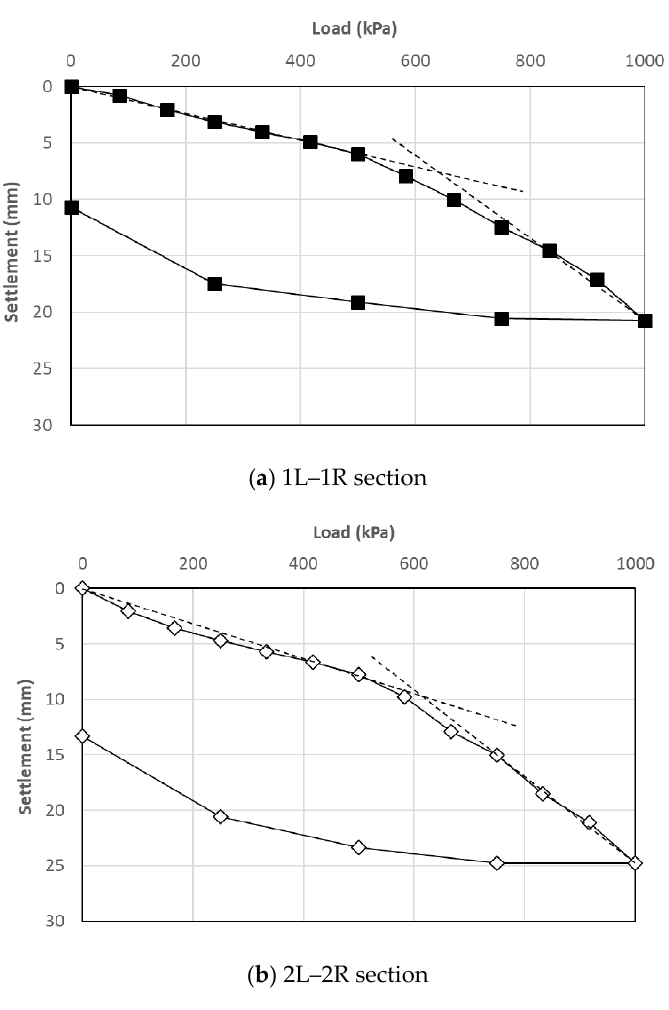
Figure 13. Estimation of bearing capacity by P-S curve method. Table 7. Bearing capacities by various methods.